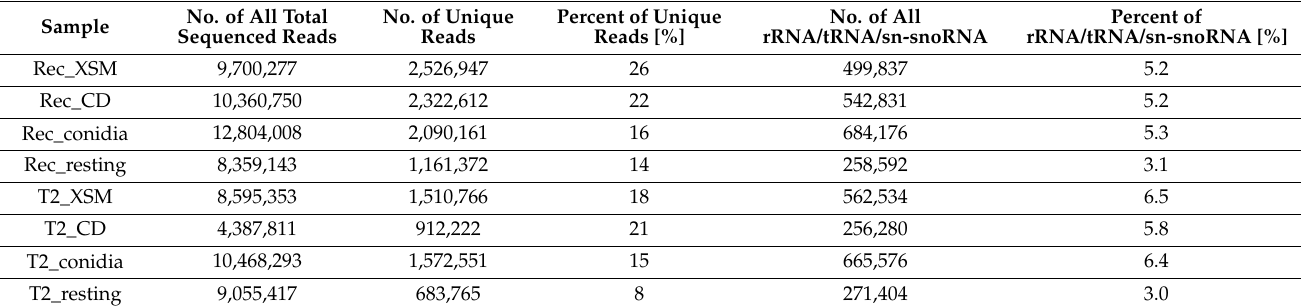
Table 1. Summary of the sequencing and distribution of sRNAs among different V. nonalfalfae samples.